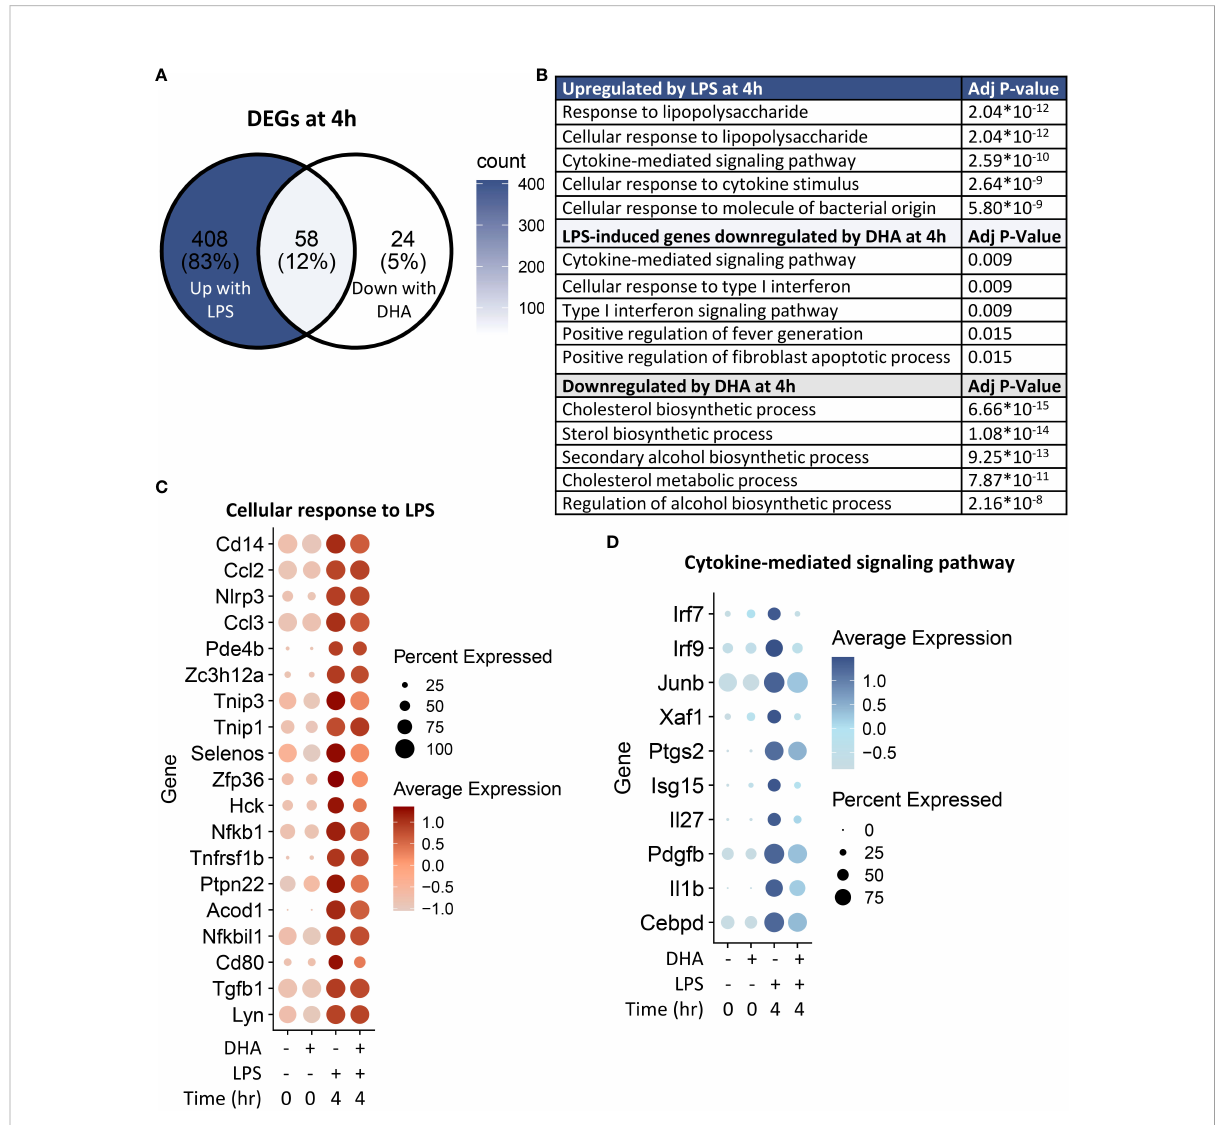
FIGURE 8 DHA inhibits in fl ammatory signaling pathways at 4 h post-LPS treatment. (A) Differentially expressed genes (DEGs) were identi fi ed by using the Seurat FindMarkers function, with thresholds set to select genes with >1.5-fold change in gene expression and genes expressed in at least 25% of groups being compared. DEGs in the “ Down with DHA ” circle of the Venn diagram are downregulated in DHA.LPS.4 relative to Veh.LPS.4 and DEGs in the “ Up with LPS ” circle of the Venn diagram are upregulated in Veh.LPS.4 relative to Veh. The intersection represents LPS-induced genes suppressed by DHA at 1h. (B) The Enrichr database was used to identify GO Biological Process terms for the indicated groups of genes. Shown are the fi ve most enriched pathways are shown, as determined by the size of the adjusted p -value. (C) Selected input genes enriched in the “ Cellular response to LPS ” and (D) “ Cytokine-mediated signaling pathway ” GO terms are depicted using the Seurat DotPlot feature, where the size of the dot indicates the percent of cells expressing the gene and the depth of the dot color indicates the average expression of the gene across the cells in which it is